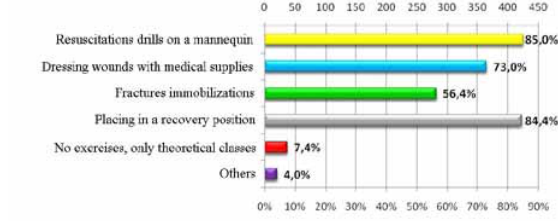
Figure 2. Methods of leading First Aid